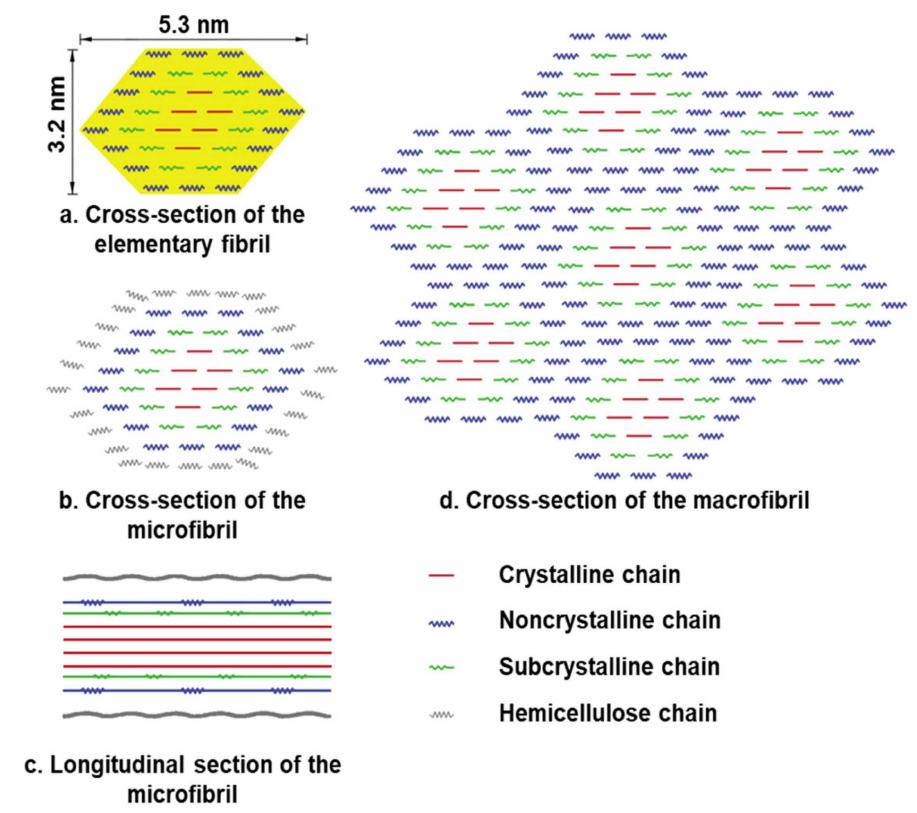
Figure 15. Secondary structure of cellulose. ( a ) Cross-section of the 36-glucan-chained elementary fibril. ( b ) Microfibril cross-section with hemicellulose coating on the surface of the elementary fibril. ( c ) The microfibril’s longitudinal section. ( d ) Macrofibril cross-section generated by elementary